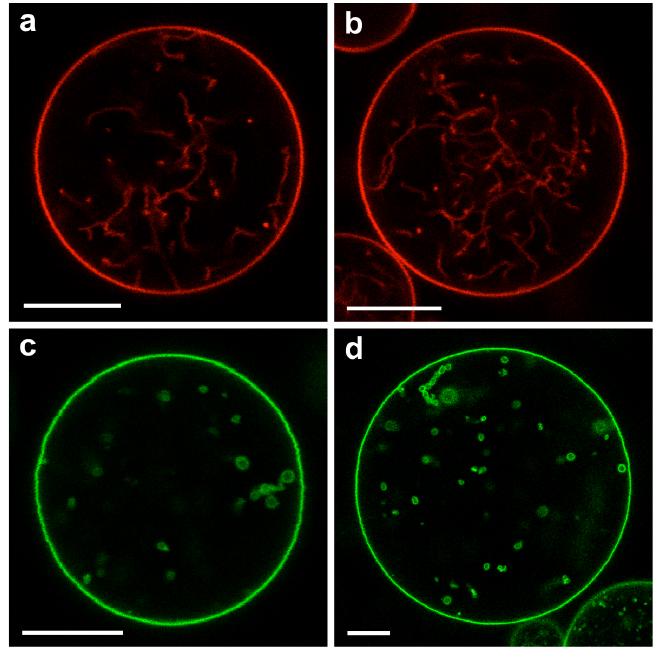
Figure 20. Nanotubes of GUV membranes with two different lipid compositions, which form a liquid-disordered lipid phase (red) in ( a , b ) and a liquid-ordered lipid phase (green) in ( c , d ). The two colors red and green arise from two different fluorescent dyes, which were added to the lipid bilayers using very small mole fractions. All vesicles are exposed to aqueous solutions of PEG 8000 and sucrose without dextran. The interior solution contains only PEG and no sucrose with the initial weight fraction w p = 0.0443 of PEG. The vesicles are deflated by exchanging the external medium by a hypertonic solution with no PEG but an increasing weight fraction w su of sucrose. The vesicles in ( a , c ) are obtained for w su = 0.0066, those in ( b , d ) for w su = 0.01. The white scale bars are 10 µ m in all panels [9].